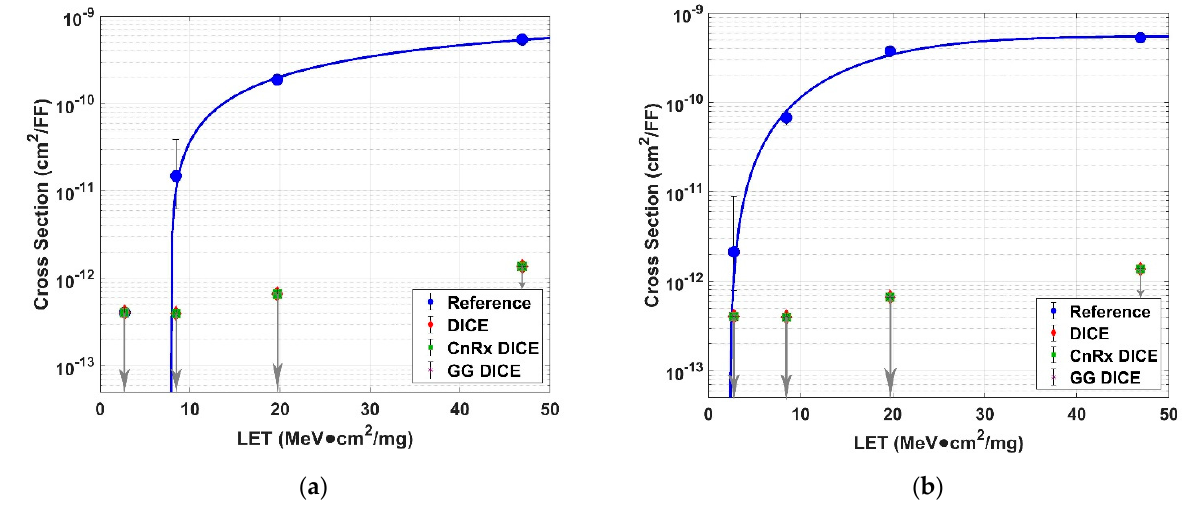
Figure 9. Cross − sectional values for heavy ion testing at a 0° incidence angle from normal, ( a ) core voltage of 0.8 V, ( b ) core voltage of 0.6 V.